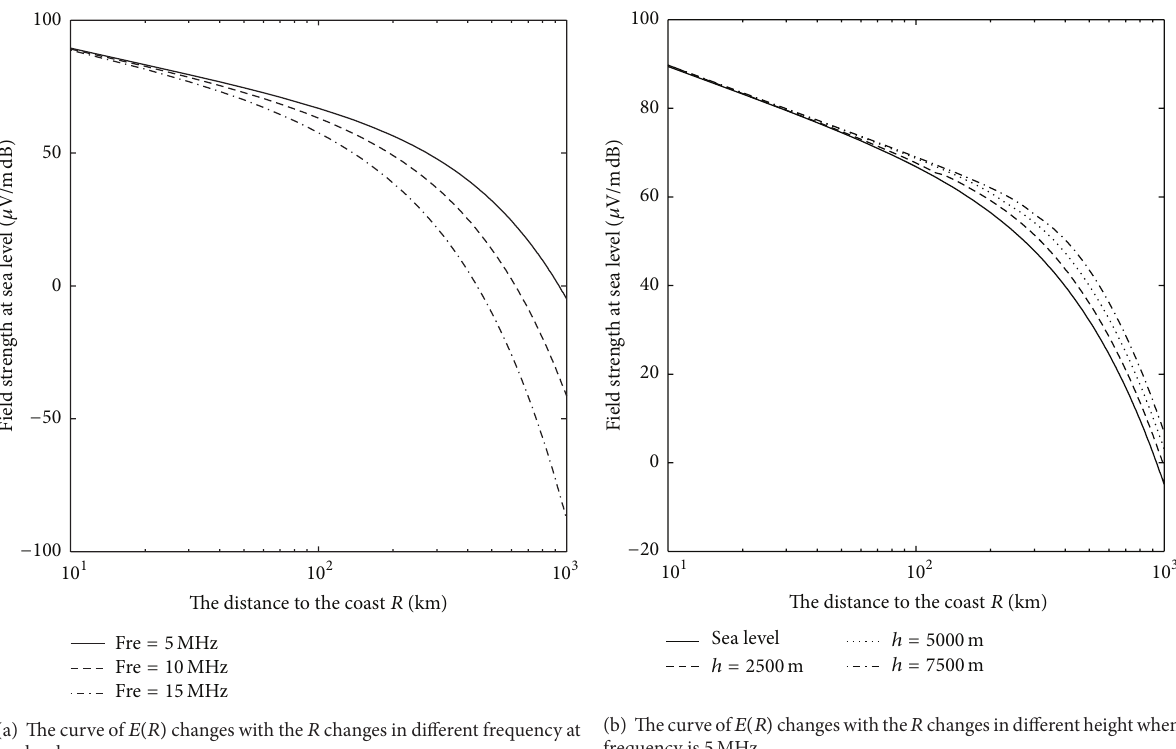
Figure 2: The characters of 𝐸(𝑅)